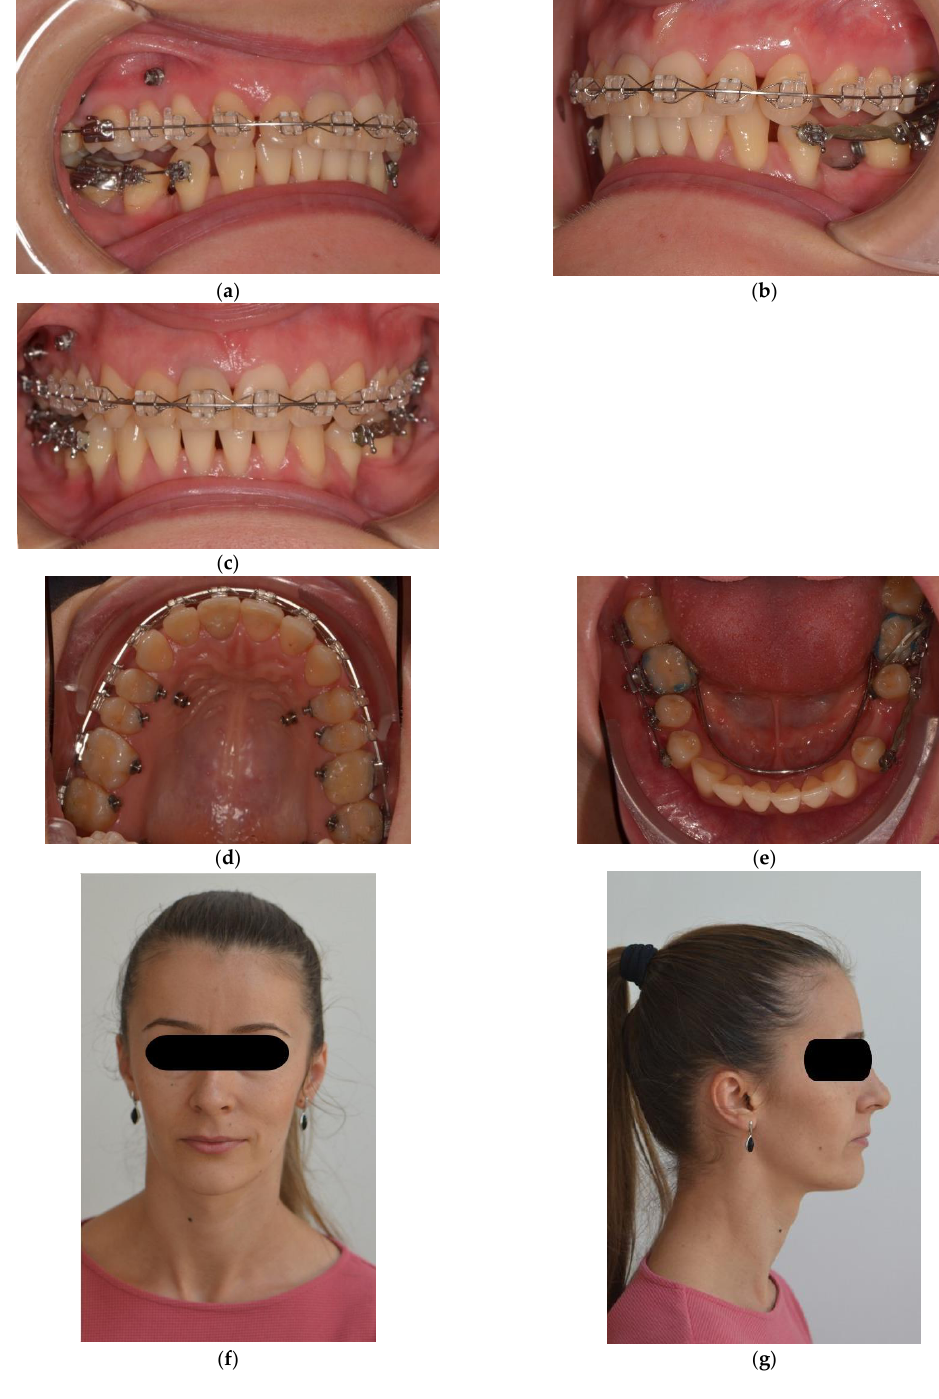
Figure 8. Post-intrusion intraoral photographs ( a , b ) Left lateral occlusal view; ( c ) Frontal occlusal view; ( d ) Upper arch; ( e ) Lower arch; Post-intrusion intraoral extraoral photos ( f ) Frontal view; ( g ) Lateral